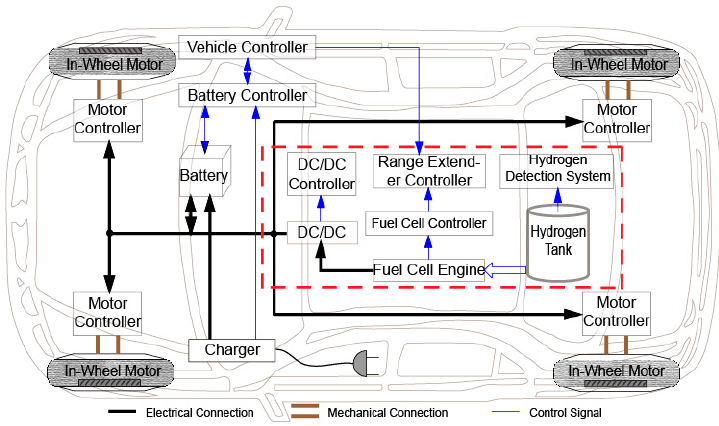
Figure 3. Structure of fuel cell electric vehicle powertrain system.